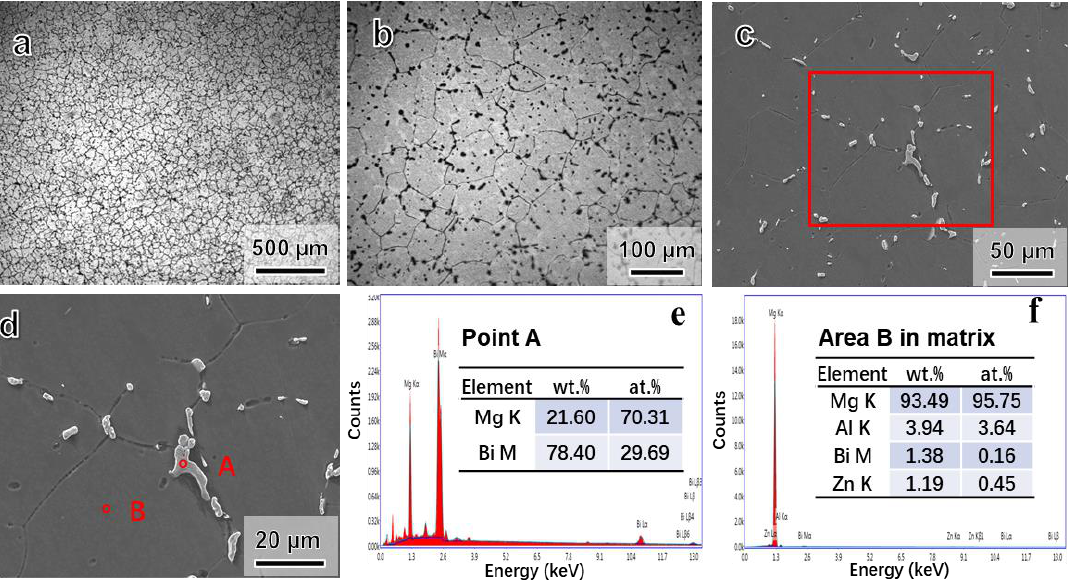
Figure 1. OM ( a , b ), SEM ( c , d ) micrographs, and EDS results ( e , f ) of as-homogenized BAZ631 alloy.